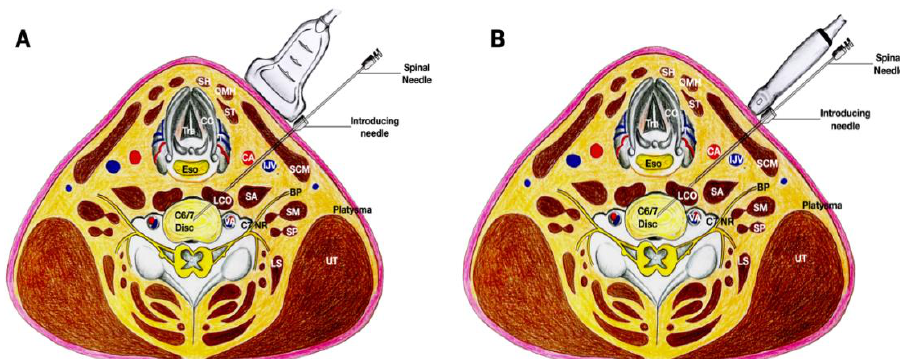
Figure 7. The figure demonstrates a variation of the medial approach, with the needle’s trajectory passing through the space between the carotid artery and the internal jugular vein. The biplanar approach can assist and validate the needle placement. ( A ) The transducer is in the transverse plane of the neck and placed more medially to the needle; an in-plane needle technique is used. ( B ) The transducer is in the sagittal plane of the neck and the needle is out-of-plane to the transducer. Ab-